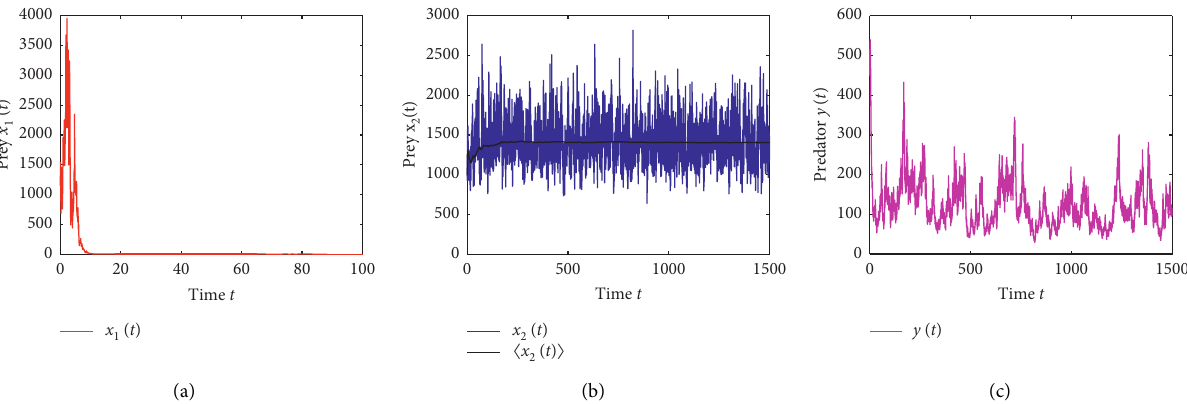
Figure 21: The trajectories of stochastic model (5) with σ 2 and (c) predator y ( t ) .